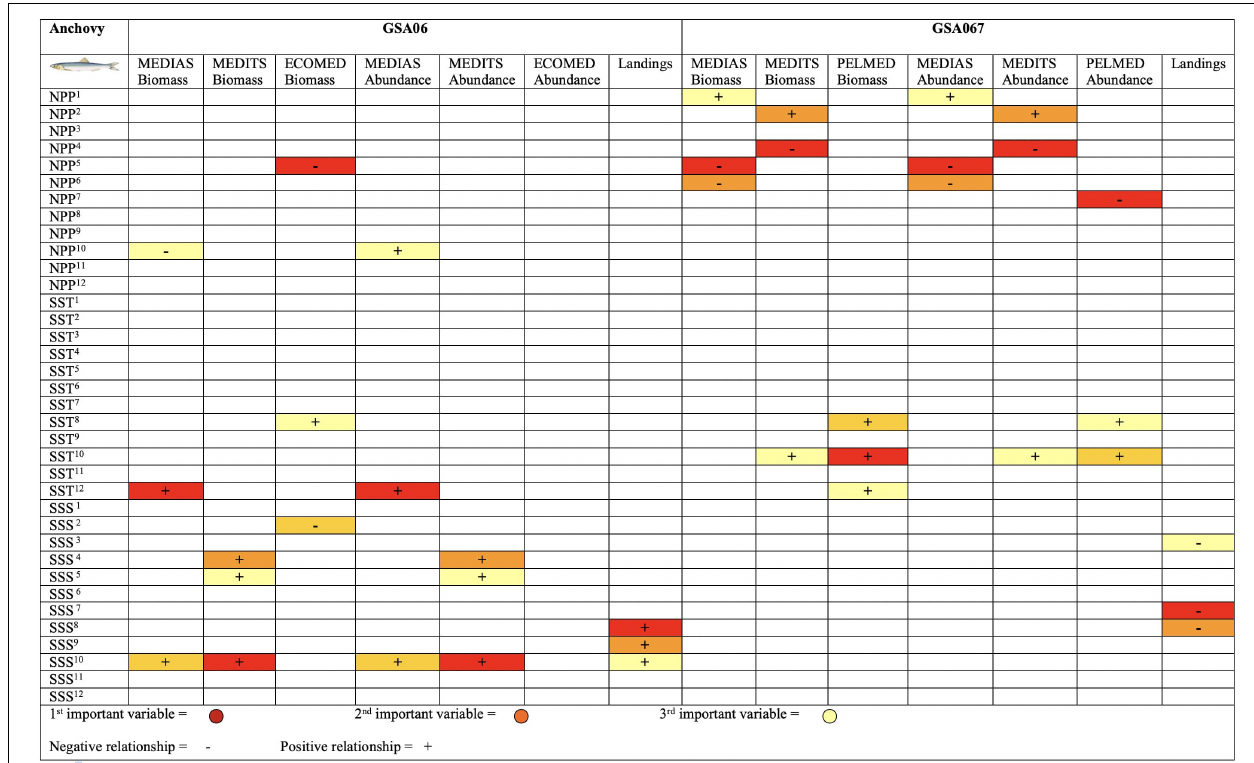
FIGURE 7 | Summary of the Random Forests results for European anchovy ( Engraulis encrasicolus ) temporal index trends in the Geographical Sub-Area 06 and 07 from 2003 to 2016. This figure shows the ecological and statistical weight of each variable. (+) symbol indicates a positive relationship of the variable with the biomass, abundance or landings and (-) symbol indicates a negative relationship. The colors represent the range, from most to least important variable within the model (red the most relevant, orange medium relevancy and yellow the least relevant) based on the per cent increase in mean squared error- MSE).